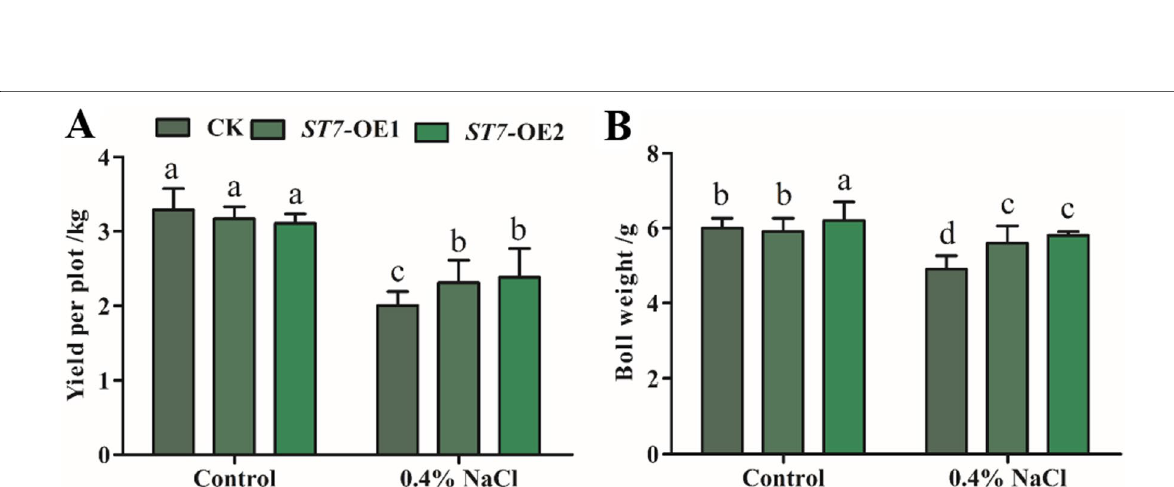
Fig. 3 DAB and NBT staining. The leaves of control, ST7 -OE1, and ST7 -OE2 plants treated with either 0 or 140 mmol ( A ) or NBT staining ( B ). Bar